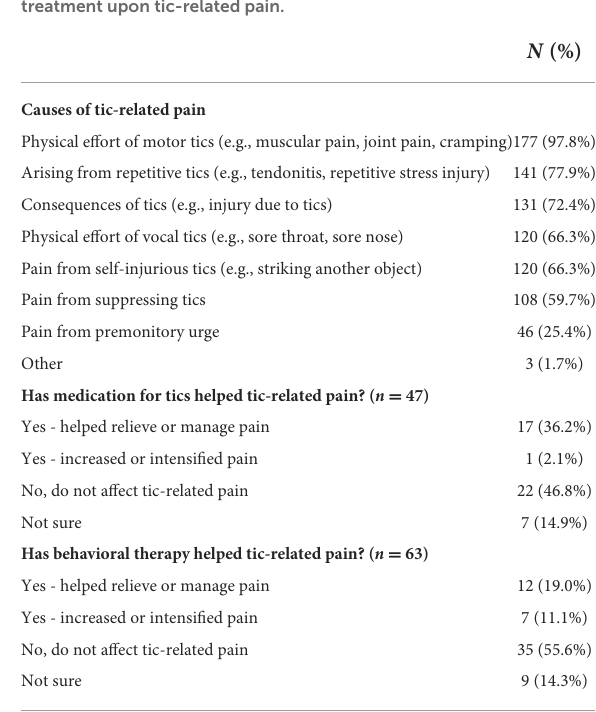
TABLE 3 Self-reported interference of tics and tic-related pain across thirteen domains in the previous week.